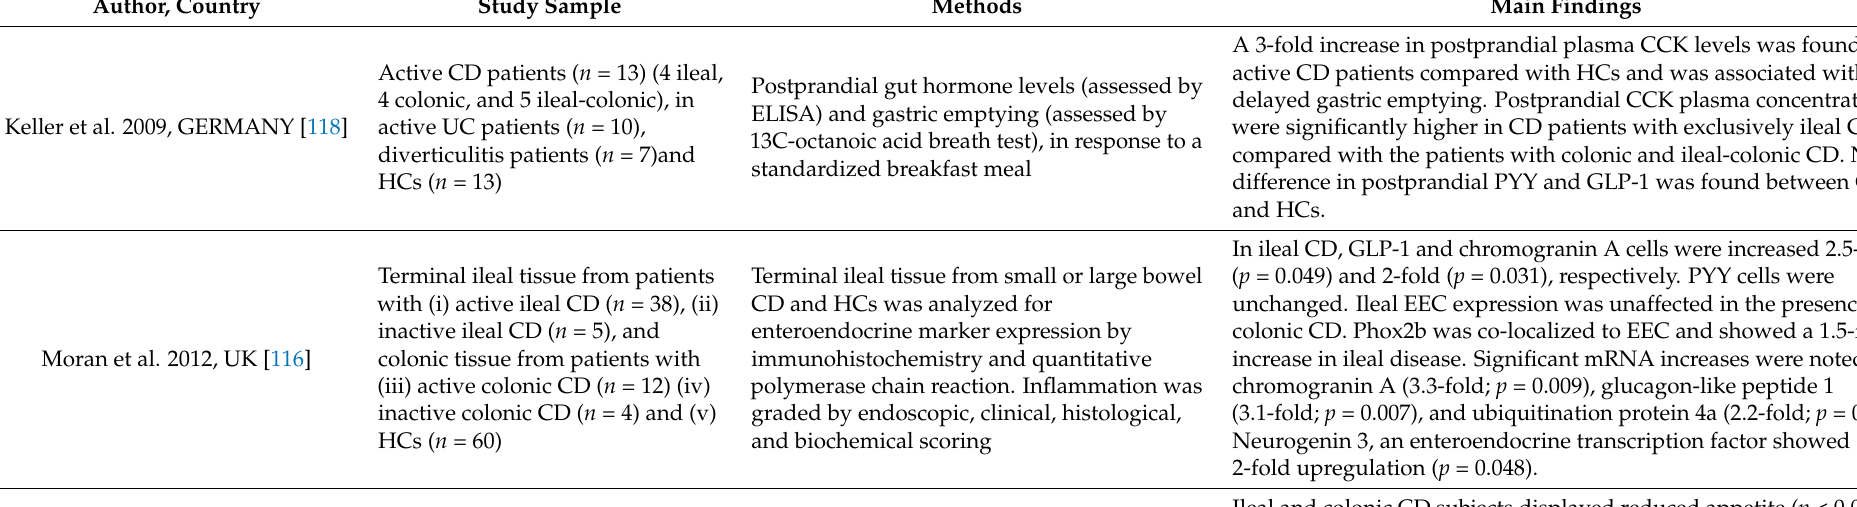
Table 1. Summary of key studies investigating the upregulation of EEC peptides, altered eating behavior, and structural and functional brain changes in intestinal inflammation. Author,